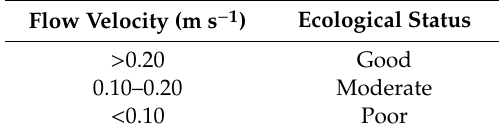
Table 4. Assessment classes according to flow velocities: saprobic index